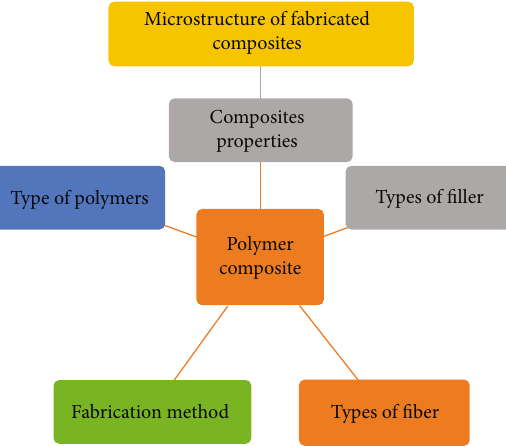
Figure 1: Methods and stages of